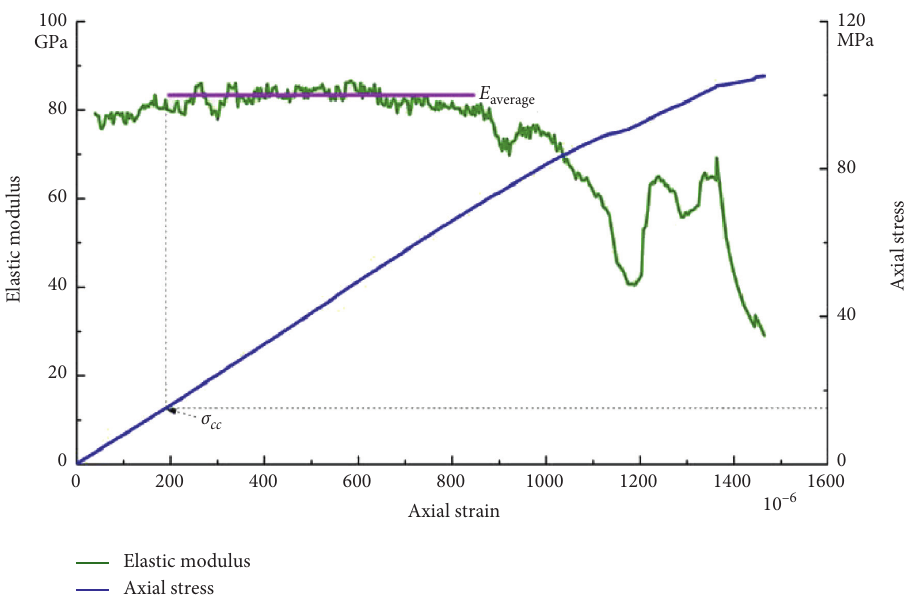
Figure 5: Young’s modulus and stress versus strain